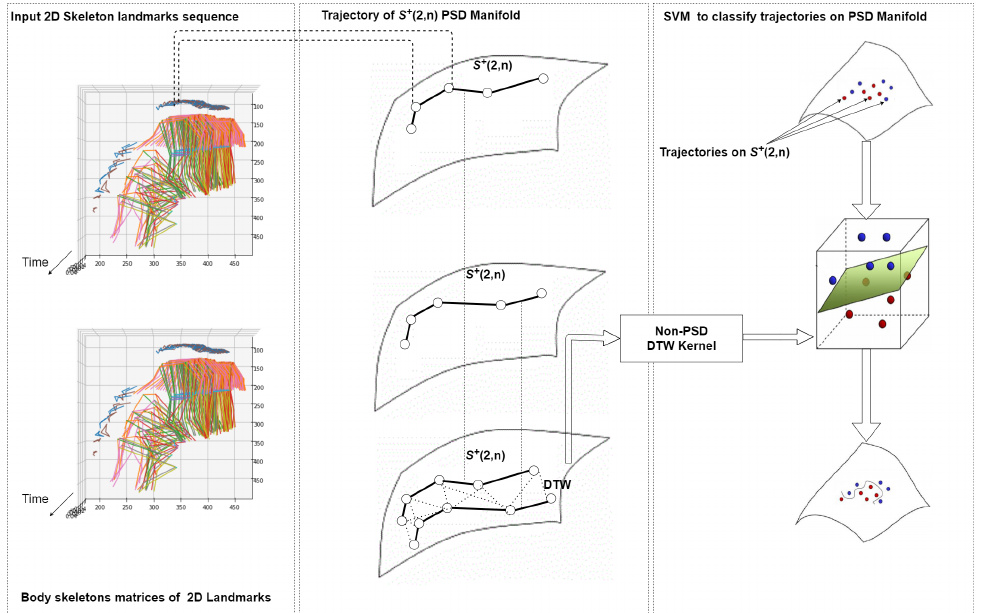
Figure 1. Overview of the proposed approach. After detecting the skeleton of a person in every frame of a sequence, a Gram matrix is computed for each frame. In this way, a sequence is represented by a trajectory of points on the manifold of positive semidefinite matrices S + ( 2, n ) . The Dynamic Time Warping (DTW) algorithm is employed to align trajectories on the manifold. Finally, a kernel generated from DTW and linear SVM are employed to classify fall and non-fall